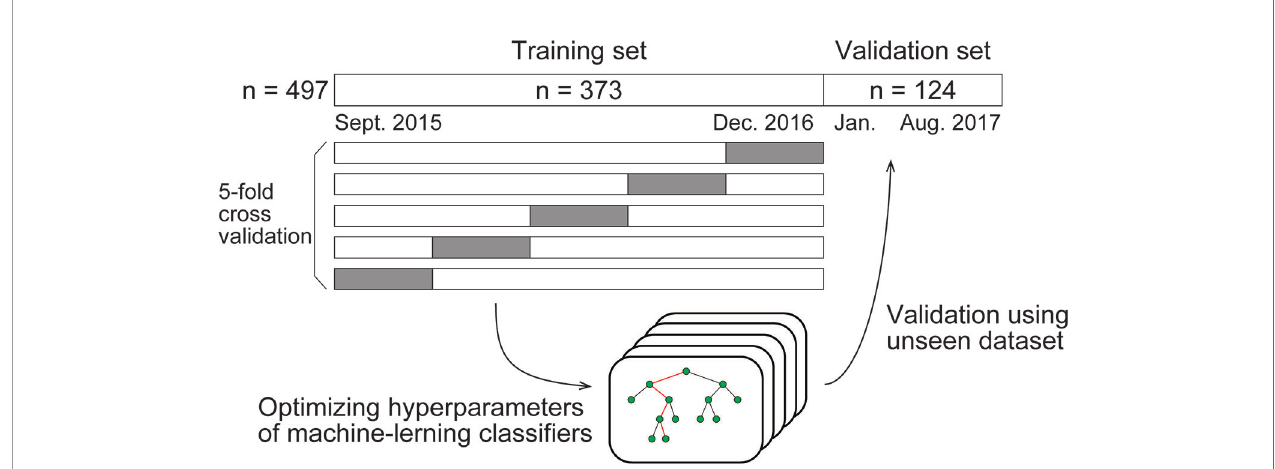
FIGURE 1 | Graphical illustration of method of